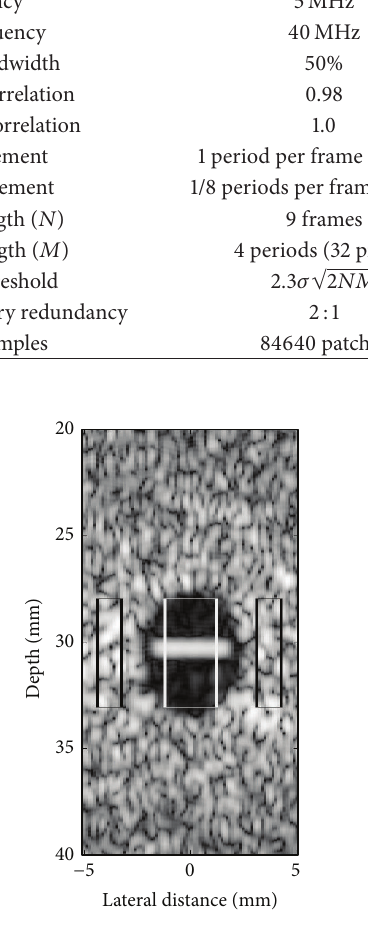
Figure 3: Region of interest used to compute CNR as in (12) for the simulated hypoechoic lesion. The white box corresponds to the ROI inside the lesion with clutter artifacts and the black boxes indicate the ROI outside the lesion.